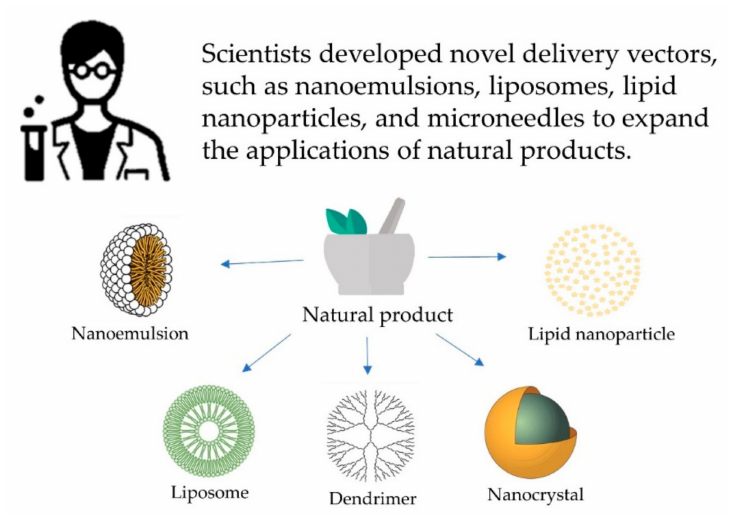
Figure 2. Scientists developed novel vector to expand the application of natural